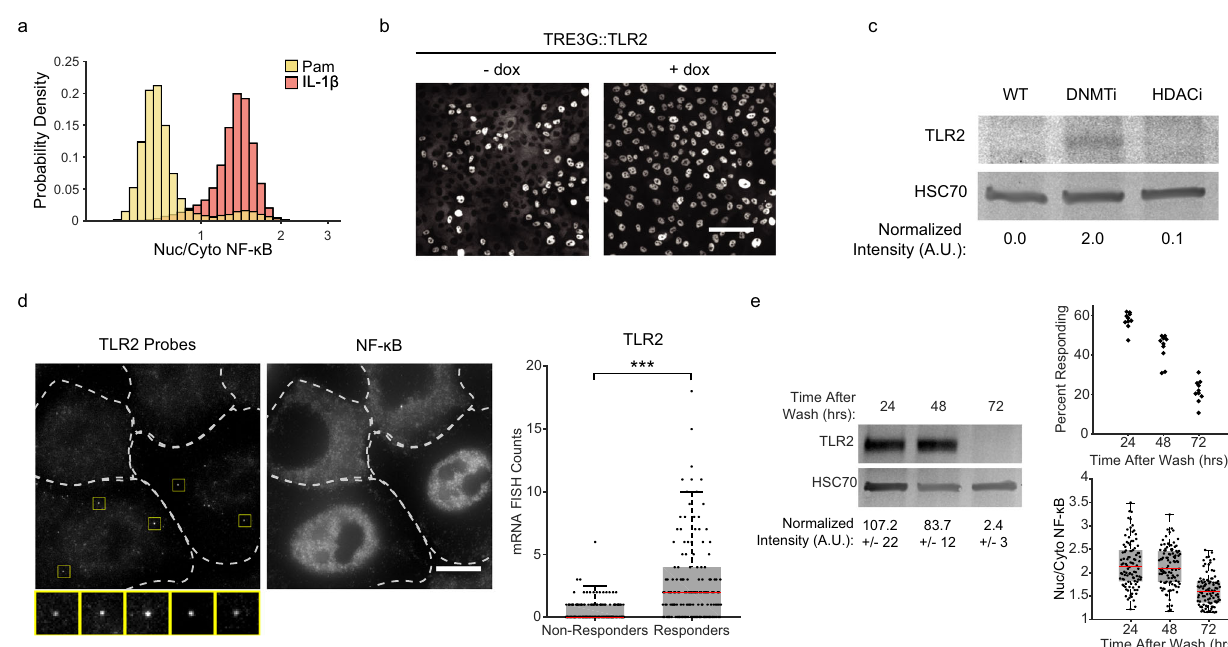
Fig. 4 Bimodal TLR2 expression limits the fraction of responder cells. a Wild-type MCF10A were stimulated with 1 µ g/ml Pam3CSK4 or 100 ng/ml IL-1 β . Quanti fi cation of nuclear/cytoplasmic p65 immuno fl uorescent stain is shown in histograms on logarithmic scale. Data represents three replicates. b Cells were transduced with TLR2 under a Tet Responsive Element 3rd Generation (TRE3G) promoter and incubated with or without Doxycycline (2 µ g/ml) for 24 h. Cells were then stimulated with 1 µ g/ml Pam3CSK4 and immunostained to determine responder status as in Fig. 2a. Representative images of three replicates are shown. Scale bar, 100 µ m. c Immunoblot against TLR2 in cells treated with or without DNMT inhibitor (5-AzacytidineC, 500 nM) or HDACi (SAHA 800 nM). HSC70 was used as a loading control. Data represents two replicates. d Dual smRNA FISH-immuno fl uorescence for TLR2 and NF- κ B was done as described in Methods section. Dashed line indicates cell boundaries, yellow squares highlight the TLR2 probes. Representative images of two replicates are shown. Scale bar, 10 µ m. Quanti fi cation of TLR2 mRNAs in responders and non-responders determined by NF- κ B nuclear translocation. N = 354 cells total (148 Responder, 206 Non-Responder), p = 3.8e-19 by χ 2 test with 9 degrees of freedom. e Western blot of TRE3G::TLR2 cells treated with a 4-h pulse of Doxycycline (2 µ g/ml) and cultured for the indicated time. Relative amounts are normalized to HSC70 loading control. Standard deviation represents two independent experiments for each condition. Swarmplots represent technical replicates of the percentage of responding cells (top) and nucleus/cytoplasm NF- ĸ B amplitude (bottom) in the same